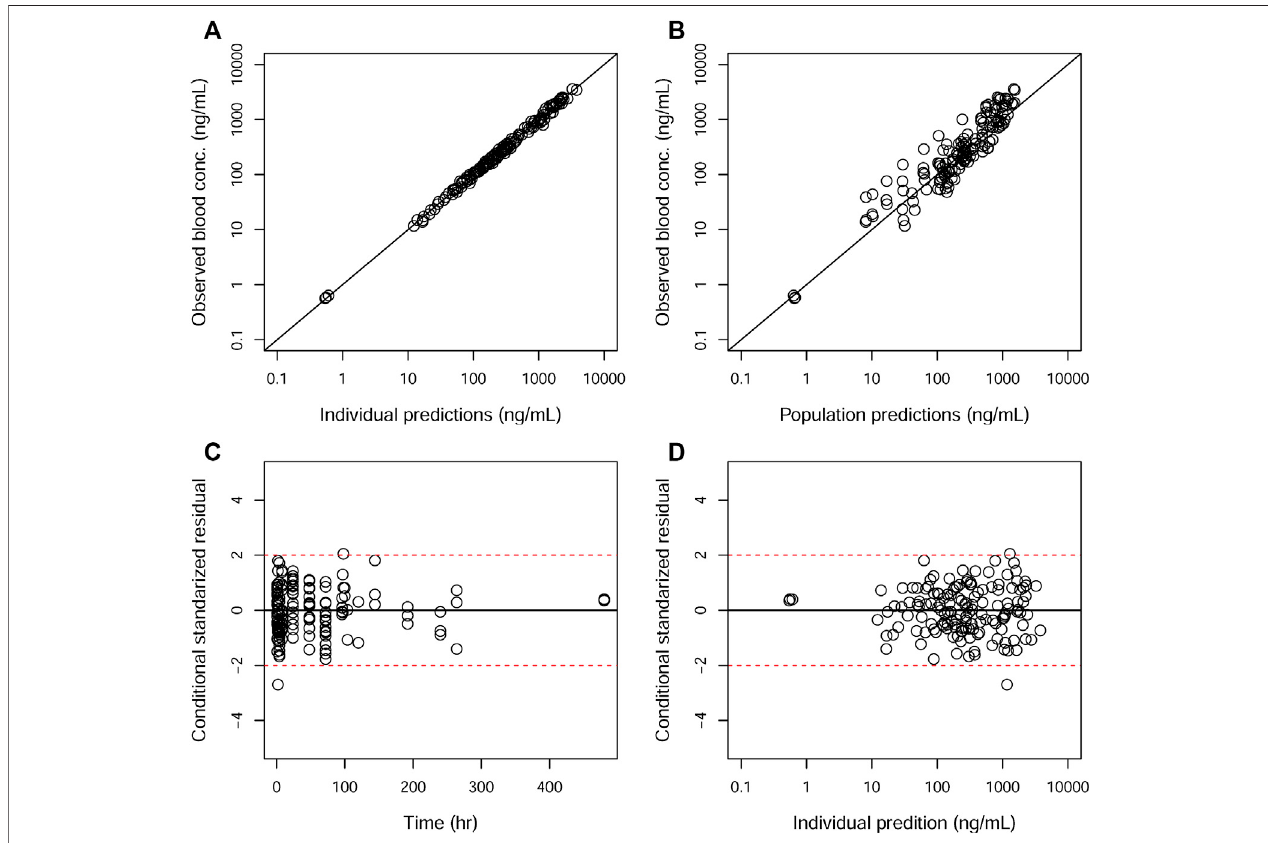
FIGURE 4 | Goodness-of- fi t plots of the blood for the fi nal model. The hollow circles represent the observed data from individual monkeys. The black diagonal (A and B) and horizontal lines (C and D) are the lines of identity and zero lines, respectively. The dashed lines in the bottom panel are the conditional standardized residual equal ±